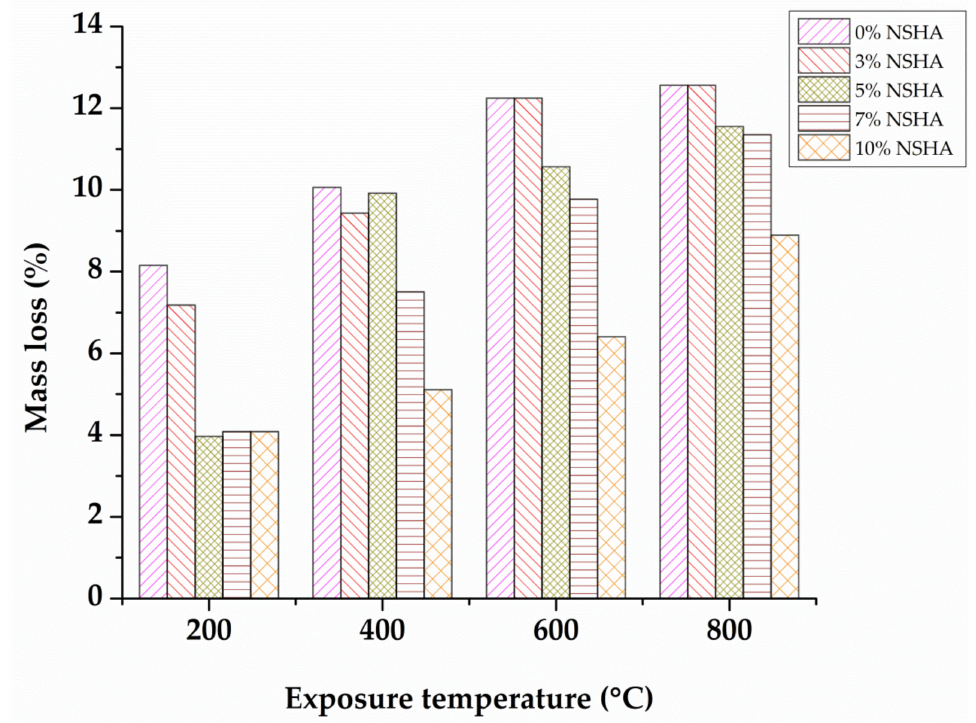
Figure 5. Mass loss versus temperature for OPC and NSHA concrete cured for 28 days.